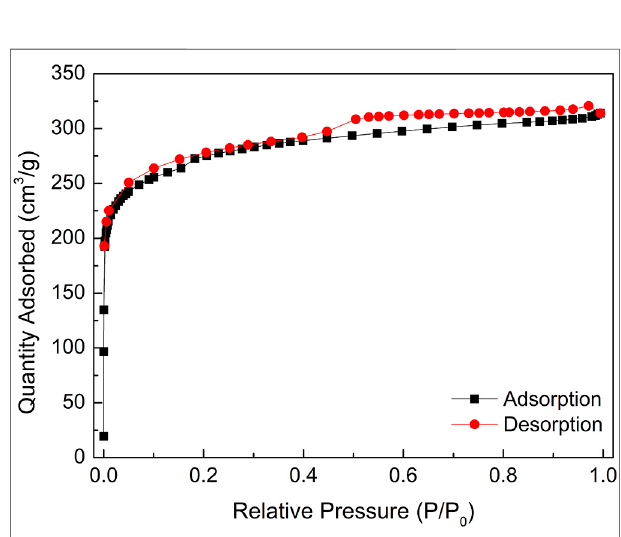
FIGURE 2 | N 2 adsorption – desorption isotherm of